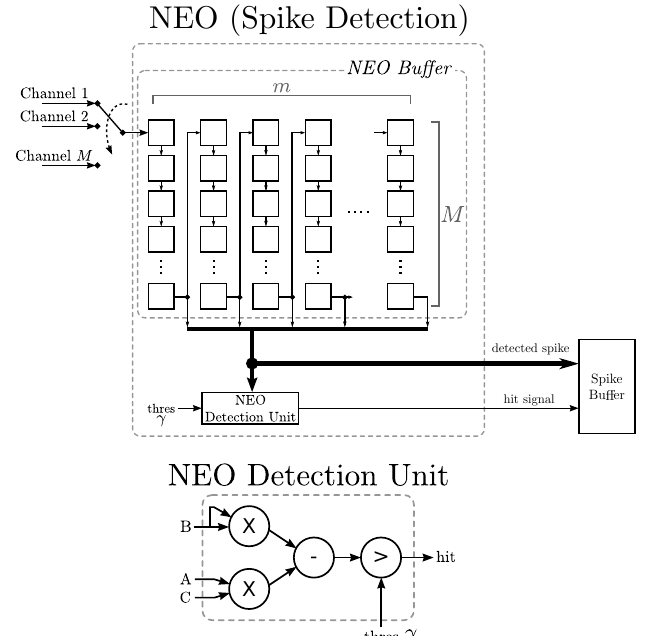
Figure 2. The architecture of the nonlinear energy operator (NEO) circuit for spike detection.